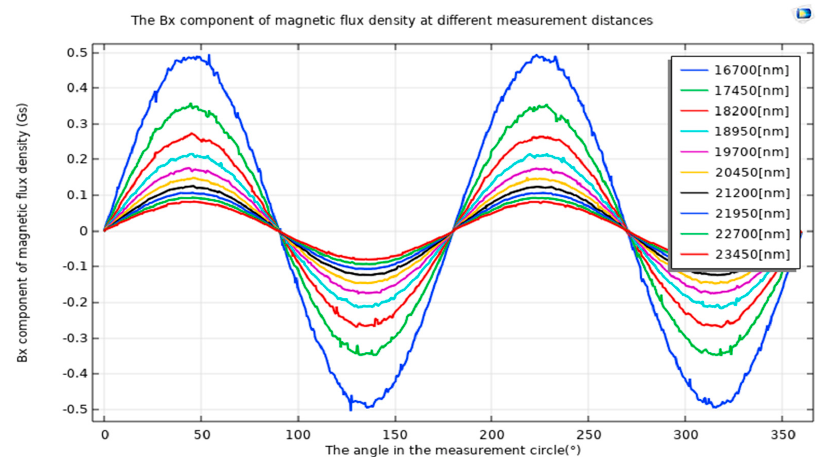
ff erent measurement